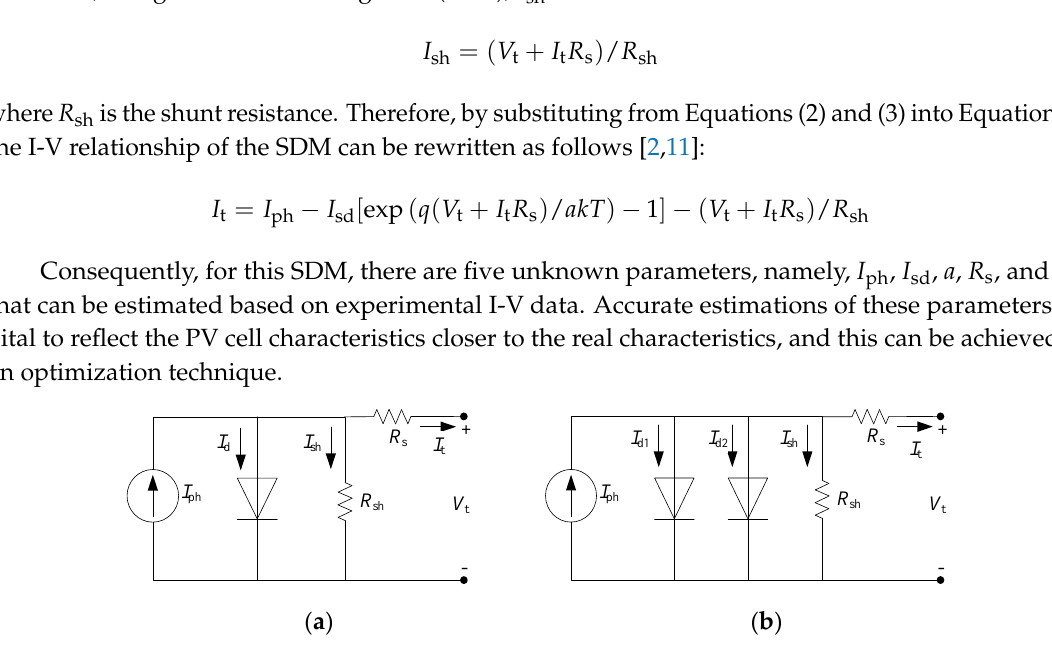
Figure 1. Equivalent circuits of a PV cell: ( a ) The SDM; ( b ) The DDM.